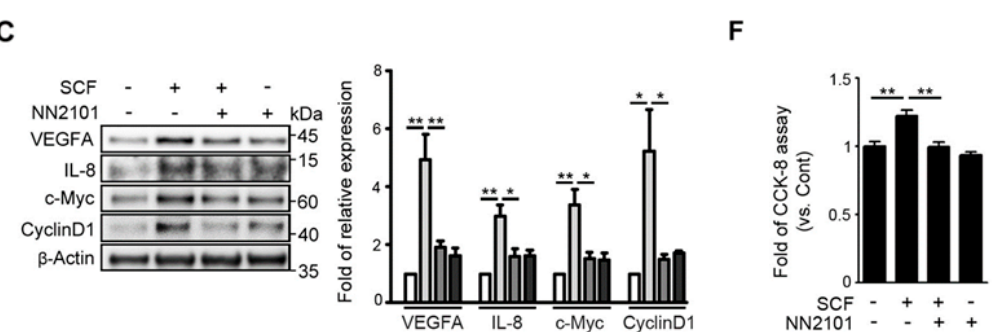
Figure 1. The anti-cKIT blocking IgG, NN2101, inhibits SCF/cKIT-mediated angiogenic signaling and angiogenesis in human endothelial cells at hypoxia. ( A ) NN2101 inhibits the SCF-induced phosphorylation of cKIT, AKT, and GSK-3 β in hypoxic endothelial cells. HUVECs cultured at hypoxia were subjected to treatment with or without recombinant human SCF (rh SCF) (50 ng/mL) and NN2101 (5 μ g/mL). Phosphorylation of cKIT (p-cKIT; arrowhead), AKT (p-AKT), and GSK-3 β (p-GSK-3 β ; Ser9) was assessed using Western blotting. Band intensities of phosphorylated proteins were normalized to those of total proteins and expressed as the fold increase ± SEM, compared to those in the untreated control group. (set as 1; one-way ANOVA with Bonferroni post hoc multiple comparison test, * p < 0.05, ** p < 0.001, n = 3). ( B ) NN2101 blocks the SCF-induced increase in the nuclear translocation of β -catenin in hypoxic endothelial cells. Nuclear and cytosolic fractions of β -catenin in cells subjected to treatment as described in ( A ) were determined by Western blotting analysis. PARP and β -Actin were used as internal loading controls for nuclear and cytosol fractions, respectively. Band intensities of the nuclear fraction of β -catenin were normalized to the PARP band intensities and expressed as the fold increase ± SEM, compared to those in the untreated control group (set as 1; one-way ANOVA with Bonferroni post hoc multiple comparison test, *** p < 0.001, n = 3). ( C ) NN2101 blocks the SCF-induced increase in the expression of β -catenin target genes in hypoxic endothelial cells. The protein levels of VEGFA, IL-8, c-Myc, and CyclinD1 were assessed as described in ( A ) (one-way ANOVA with Bonferroni post hoc multiple comparison test, * p < 0.05, ** p < 0.01, n = 3). ( D – F ) NN2101 suppresses the SCF-induced angiogenesis in hypoxic endothelial cells. Tube formation ( D ), scratch wound migration ( E ), and cell proliferation assays ( F ) were performed with HUVECs subjected to treatment with or without rh SCF (50 ng/mL) and NN2101 (1 µ g/mL) at hypoxia. Tube formation and scratch wound migration were quantified by measuring the tube length and relative area covered by cells that had migrated from the wound edges, respectively. Cell proliferation was determined using a cell counting kit-8 assay. The data are expressed as the fold increase ± SEM compared to that in the untreated control group (Cont) (one-way ANOVA with Bonferroni post hoc multiple comparison test, * p < 0.05, ** p < 0.01, n > 4). Scale bars = 200 µ